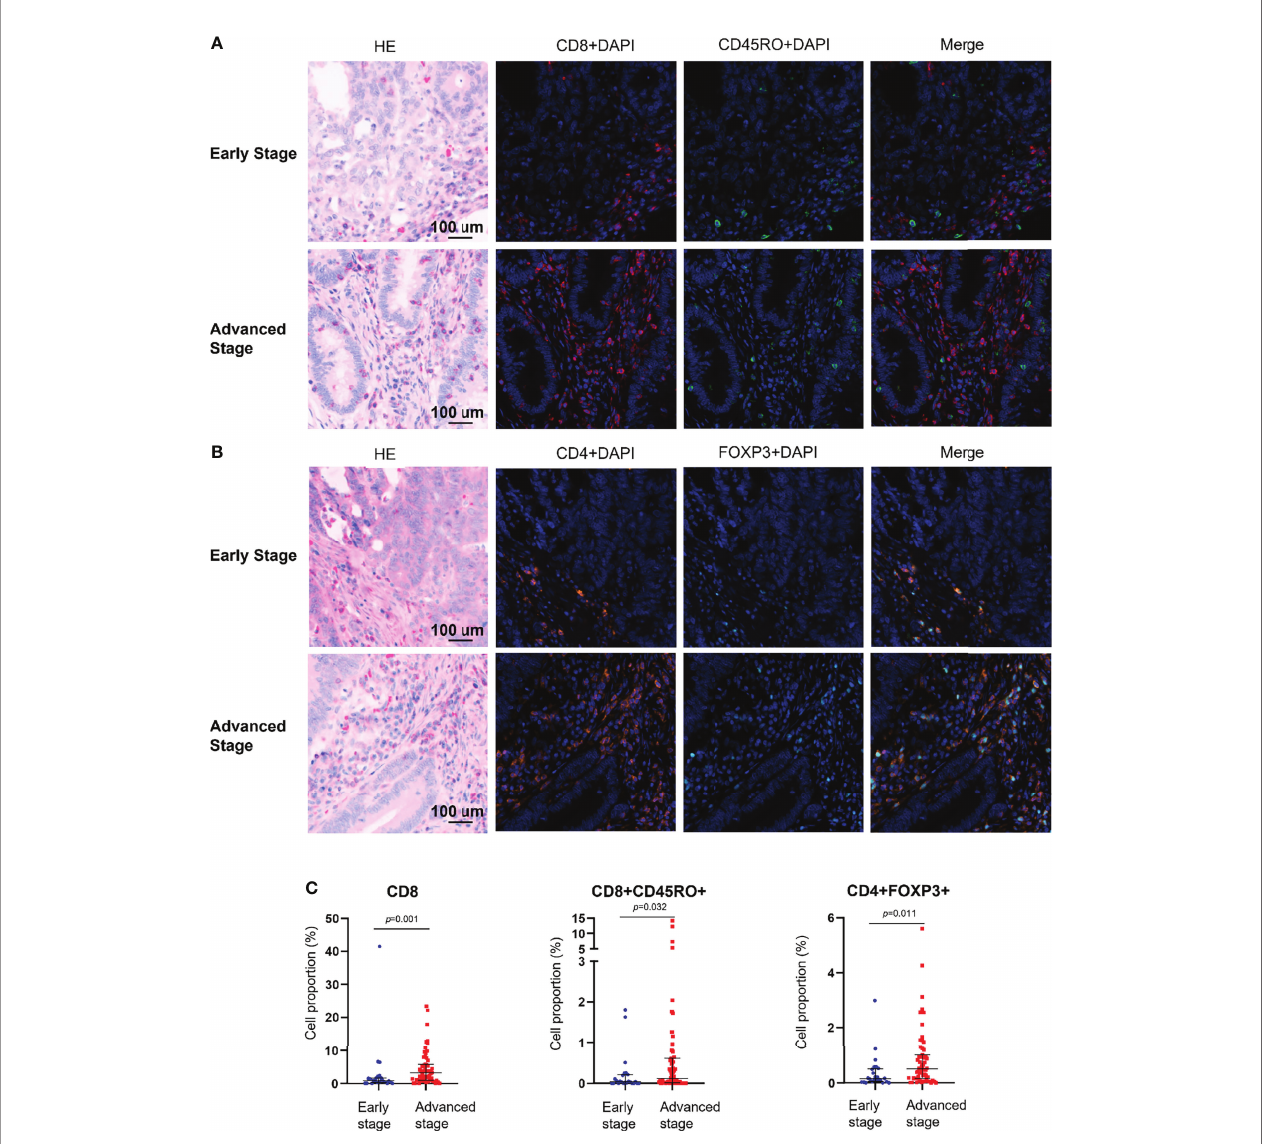
FIGURE 2 | Multiplex immunohistochemical analysis of the immune composition of early-stage and advanced-stage dMMR tumors. (A) Representative images of CD8+ and CD45RO+ cells. (B) Representative images of CD4+ and FOXP3+ cells. (C) Pairwise comparison of the densities of intraepithelial immune cells between early-stage tumors and advanced-stage tumors. Nuclei (DAPI, blue), CD8 (cytoplasm, Opal 690, red), CD45RO (cytoplasm, Opal 520, green), CD4 (cytoplasm, Opal 690, orange), and Foxp3 (membrane, Opal 570,